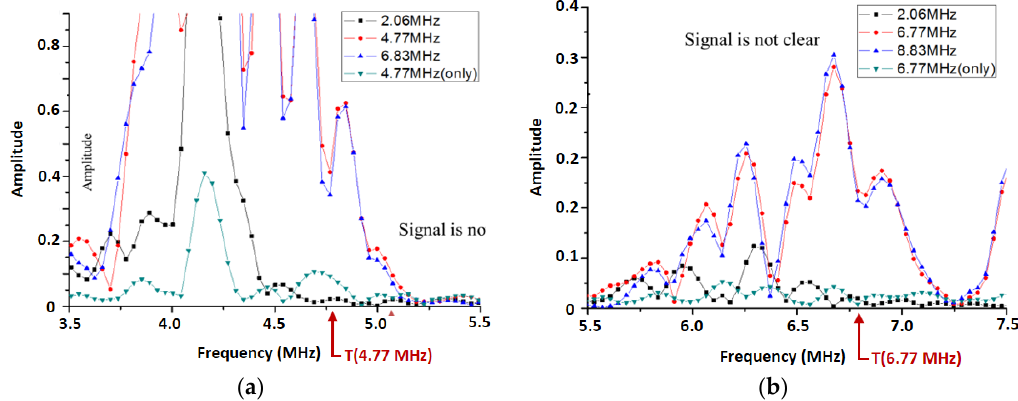
Figure 13. Frequency analysis results: ( a ) A1 mode, forward direction 𝑢(6.83 MHz) + 𝑣(2.06 MHz) → 𝑣(4.77 MHz) ; ( b ) A1 mode, inverse direction 𝑢(8.83 MHz) + 𝑣(2.06 MHz) → 𝑣(6.77 MHz) . Table 3. Data used for analysis, u ( 7.83 MHz ) + v ( 2.06 MHz ) → v ( 5.77 MHz ) . No. Type of